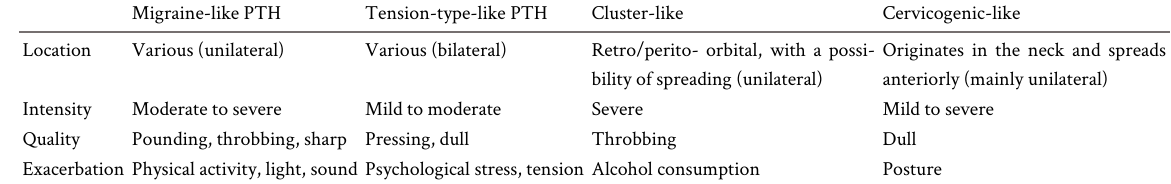
Originates in the neck and spreads anteriorly (mainly unilateral)